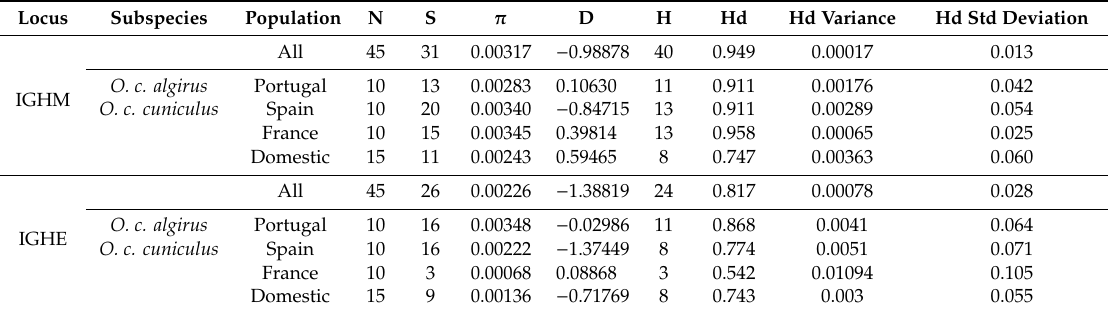
IGHM and IGHE nucleotide sequence polymorphism and estimates of haplotype diversity, haplotype diversity variance and haplotype standard deviation in the European rabbit populations / domestic animals studied.